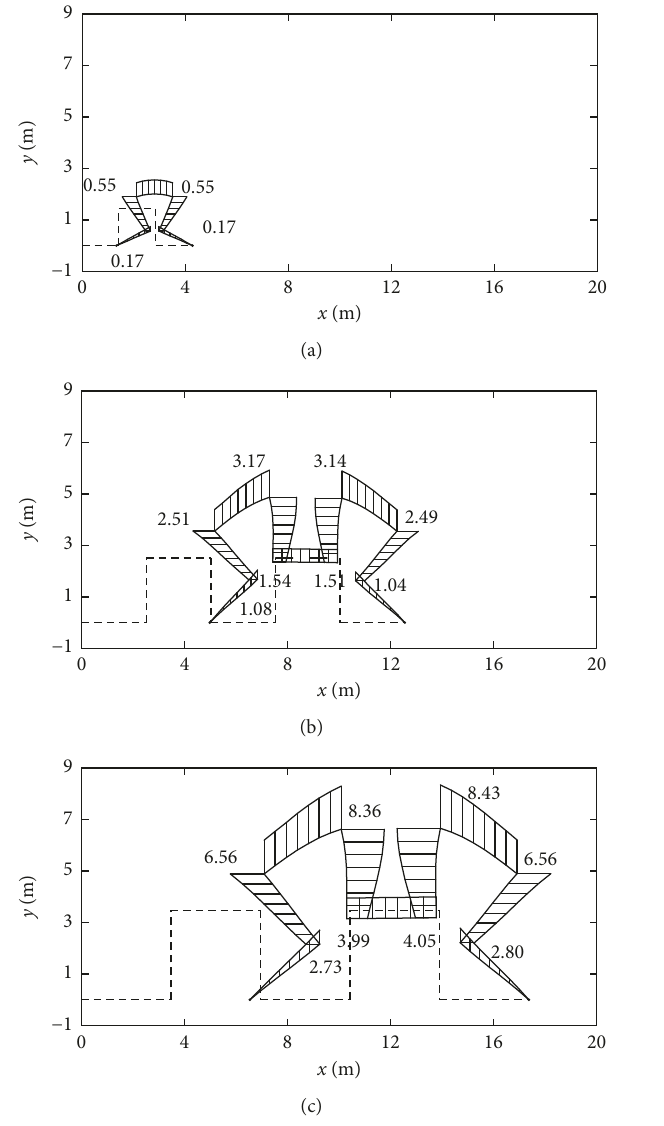
Figure 20: Maximum bending moment diagrams of the optimum devices during impact and deflections of the structures after the impact corresponding to the impact scenarios (a) IS 31 , (b) IS 32 , and (c) IS 33 (unit: MNm). , original shape of the device; , deformed shape of the device.